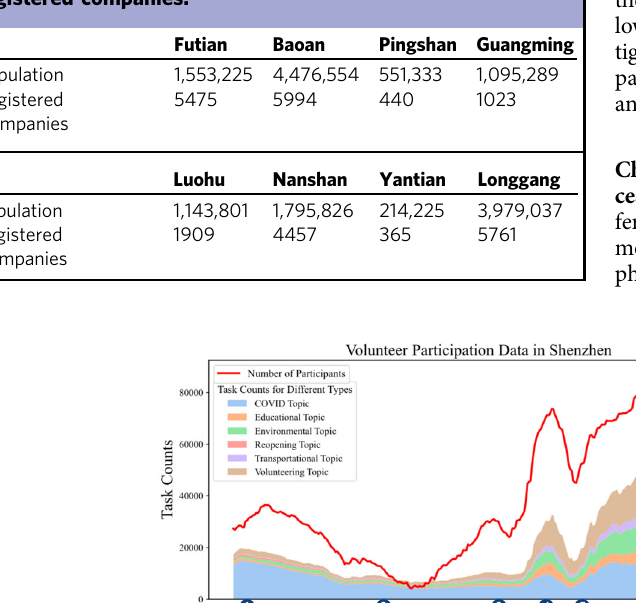
Table 1 Regional statistics of population density and registered companies.